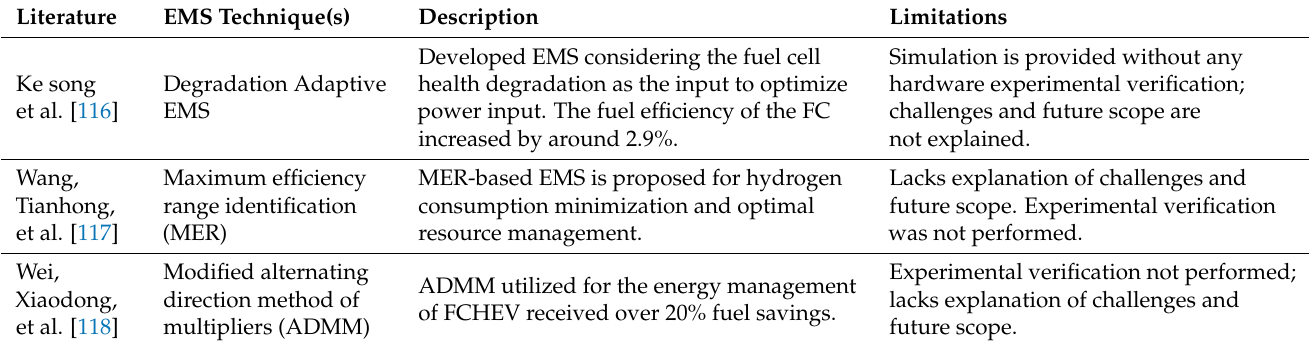
Table 13. Standalone EMS